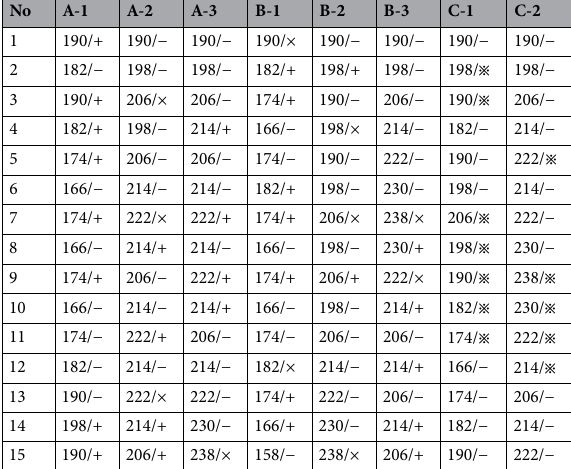
Table 3. Stress levels and experimental results for 8 groups of specimens (Unit: